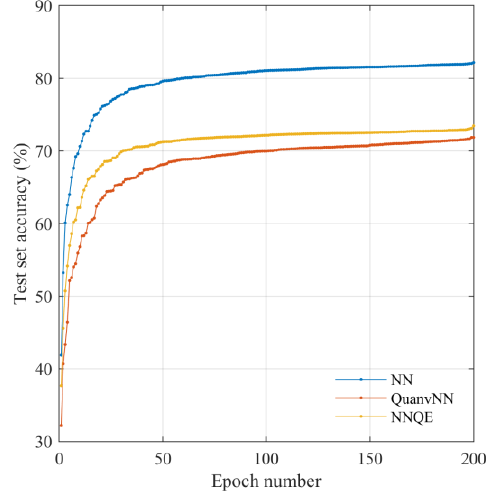
Figure 10. Test set accuracy against GTSRB dataset images.